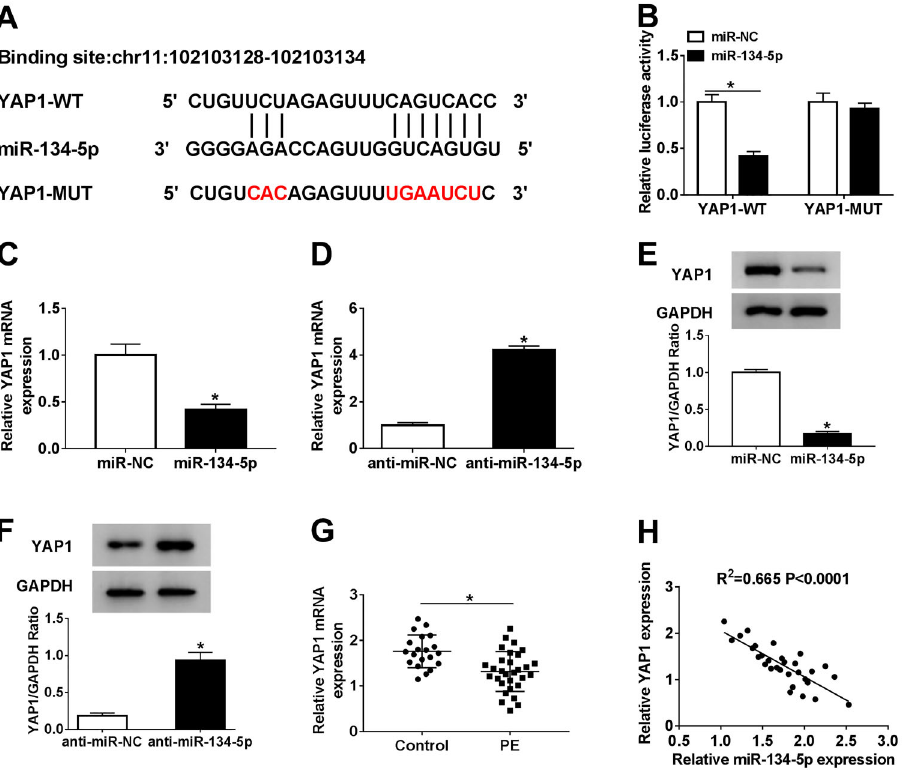
Figure 5. A , The complementary binding sites between YAP1 wild type (WT) and miR-134-5p are shown, as well as the sequences of YAP1 mutant (MUT). B , The luciferase activity of YAP1-WTor YAP1-MUT in HTR8/SVneo cells transfected with miR-134-5p or miR-NC (negative control) was assessed via dual-luciferase reporter assay. C and D , The level of YAP1 in HTR8/SVneo cells transfected with miR-134-5p, anti-miR-134-5p, or NC was measured by qRT-PCR. E and F , The protein level of YAP1 in HTR8/SVneo cells transfected with miR-134-5p, anti-miR-134-5p, or NC was detected via western blot. G , The level of YAP1 in preeclampsia (PE) tissues and normal pregnant placenta tissues was tested by qRT-PCR. H , The correlation between YAP1 and miR-134-5p was measured. Data are reported as means ± SD. *P o 0.05 (Student ’ s t